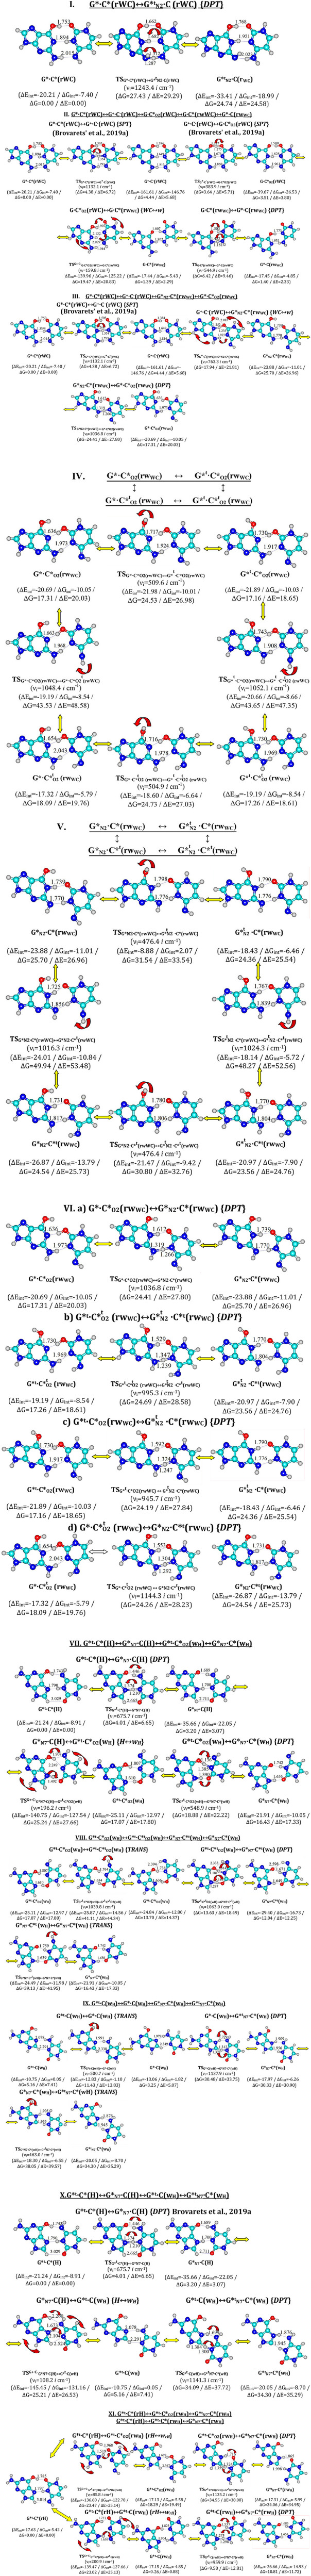
Investigated pathways of the tautomeric wobblization of the biologically-important G·C nucleobase pairs – G*·C*(rWC), G*·C*(H) and G*·C*(rH) pairs obtained at the MP2/6-311++G(2df,pd)//B3LYP/6-311++G(d,p) level of QM theory. ΔG-relative Gibbs free energy and ΔE-electronic energy (in kcal·mol−1; MP2/6-311++G(2df,pd)//B3LYP/6-311++G(d,p) level of QM theory); ΔEint-electronic and ΔGint-Gibbs free energies of the interaction (MP2/6-311++G(2df,pd)//B3LYP/6-311++G(d,p) level of QM theory, in kcal·mol−1). νi–imaginary frequency. Intermolecular AH…B H-bonds are designated by dotted lines, their lengths H…B are presented in angstroms.